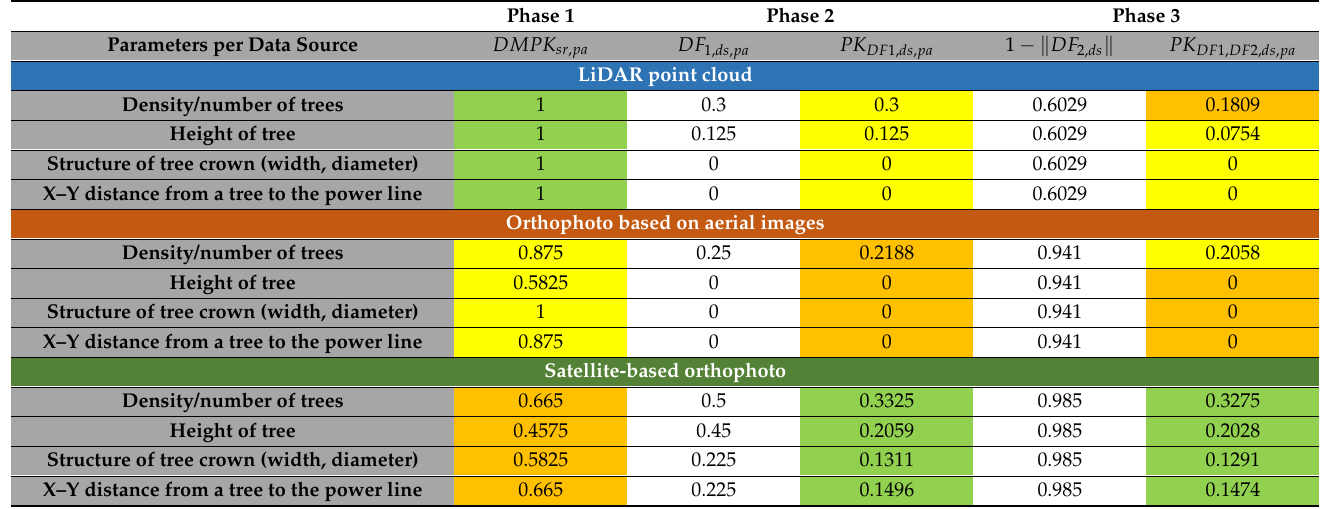
Table 25. Spatiotemporal- and trust-influenced informative potential assessment per datasets per